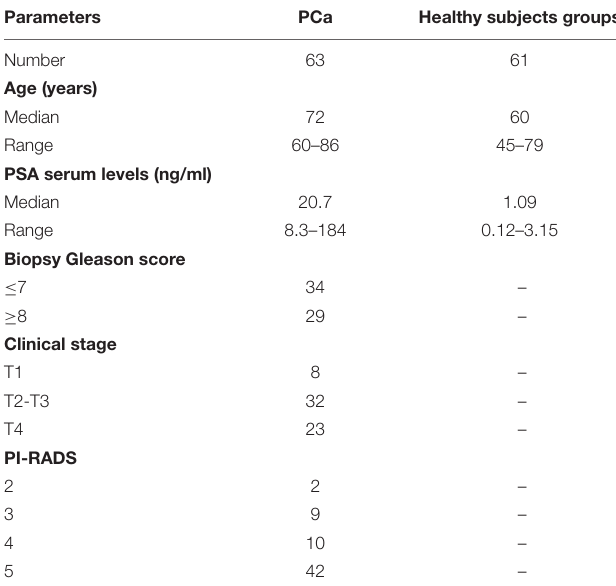
TABLE 1 | Demographic and clinicopathological characteristics of the patients included in the study.